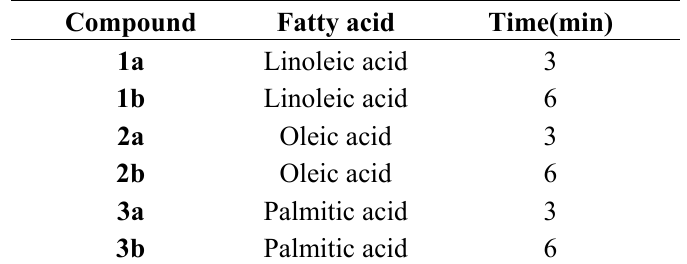
Table 1. Pectin derivatives synthesized by microwave irradiation.